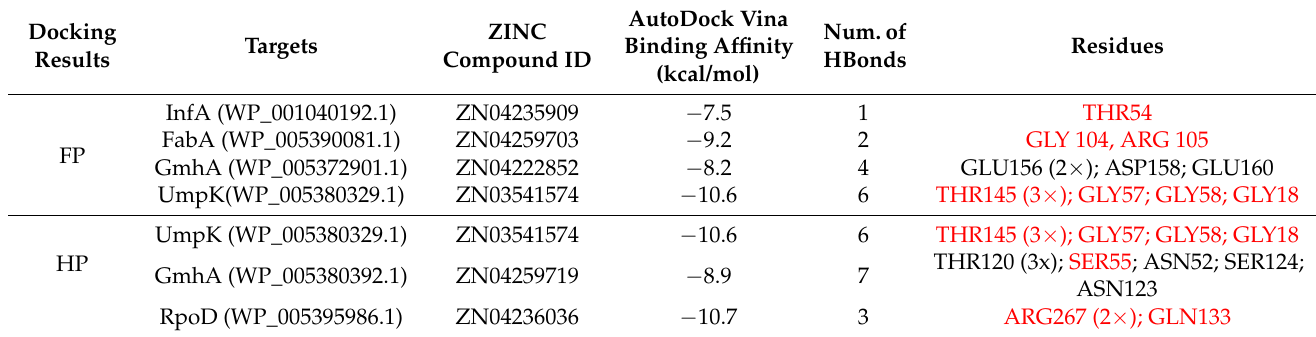
Table 5. Resumed Docking analysis. Docking results for each target in each group, the ZINC compound bound with more affinity, the binding energy and hydrogen bonds, and their residue positions